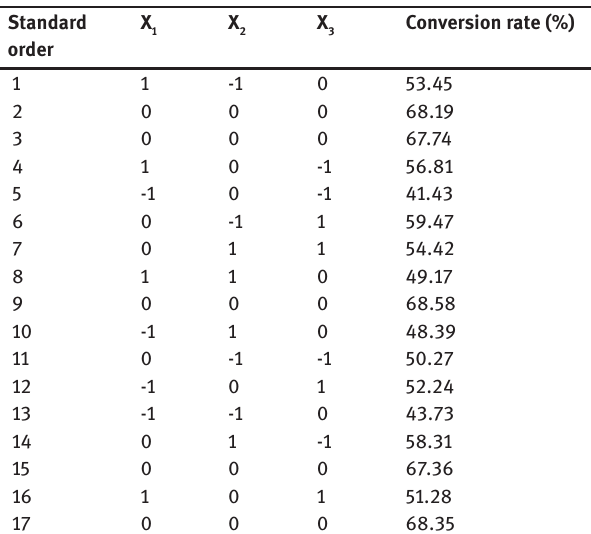
Table 2: Box-Behnken design matrix and response values showing the conversion rate of ginsenoside Rg3( S